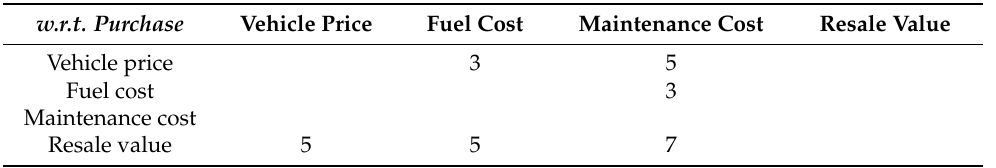
Table 8. Pairwise comparison matrix of sub-criteria of COST OF OWNERSHIP with respect to PURCHASE decision.